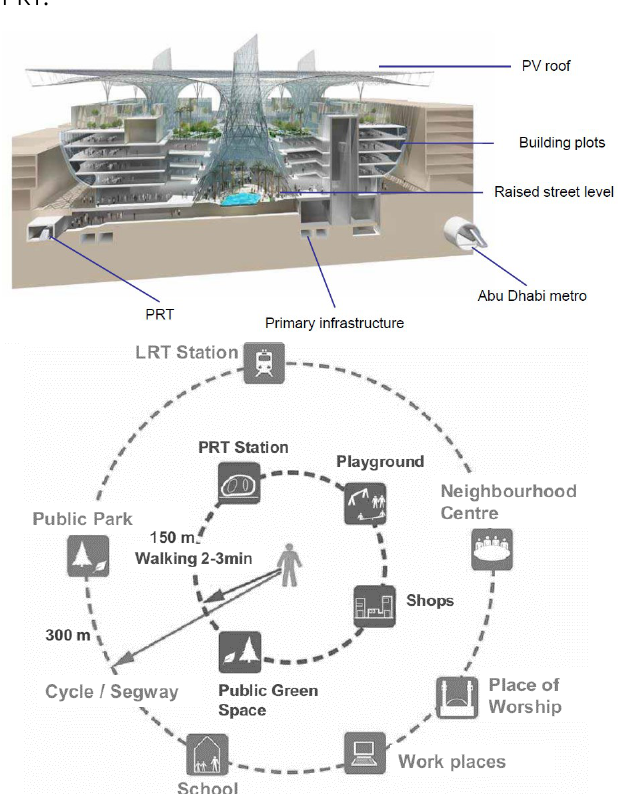
Figure 4. The conception section of the Masdar HQ, the biggest office building in the City and the distance by walk to LRT (light rail transport) and PRT (personal rail